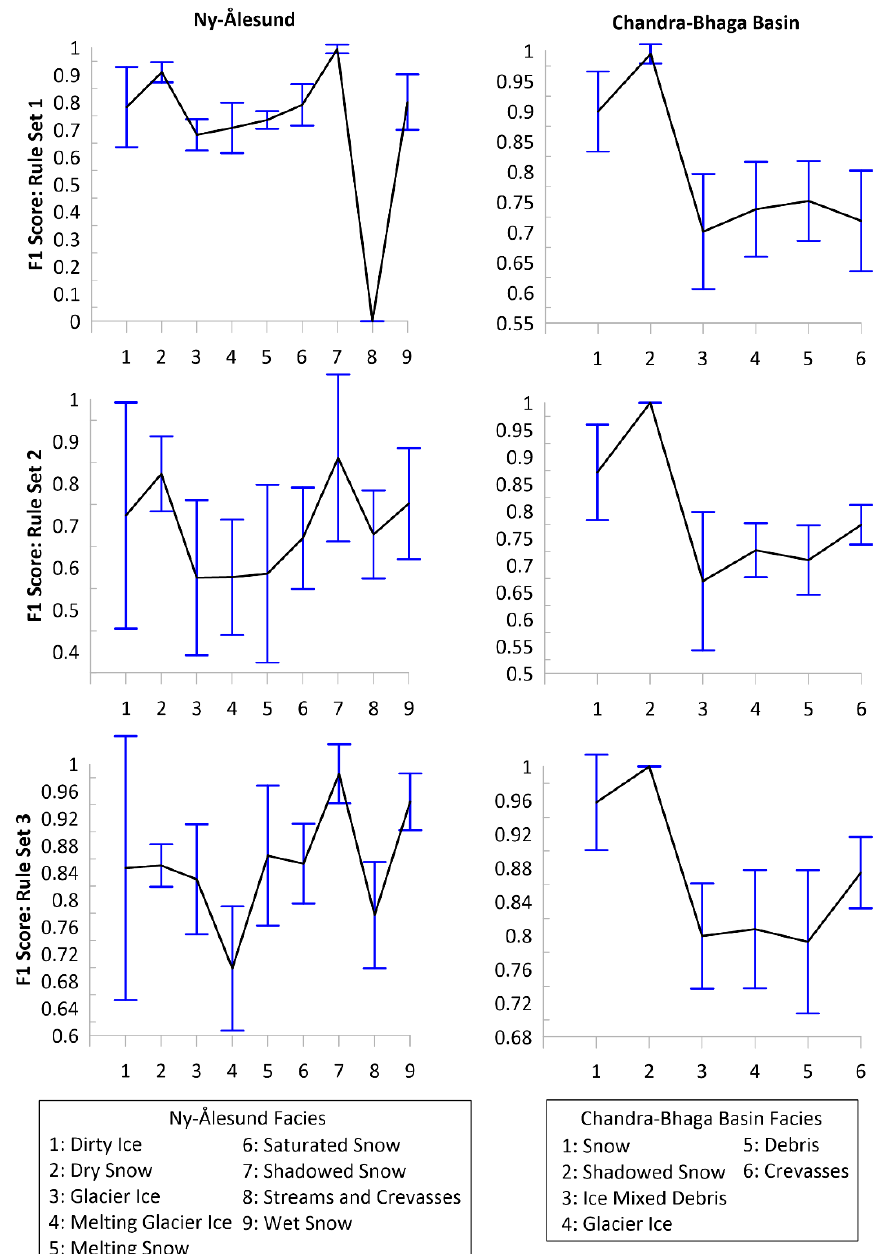
Figure 7. F1 score of each facies for the three rule sets as the mean of all processing schemes. The error bars in blue highlight deviations from the mean F1 score indicating reliability of the rule sets for the respective facies.